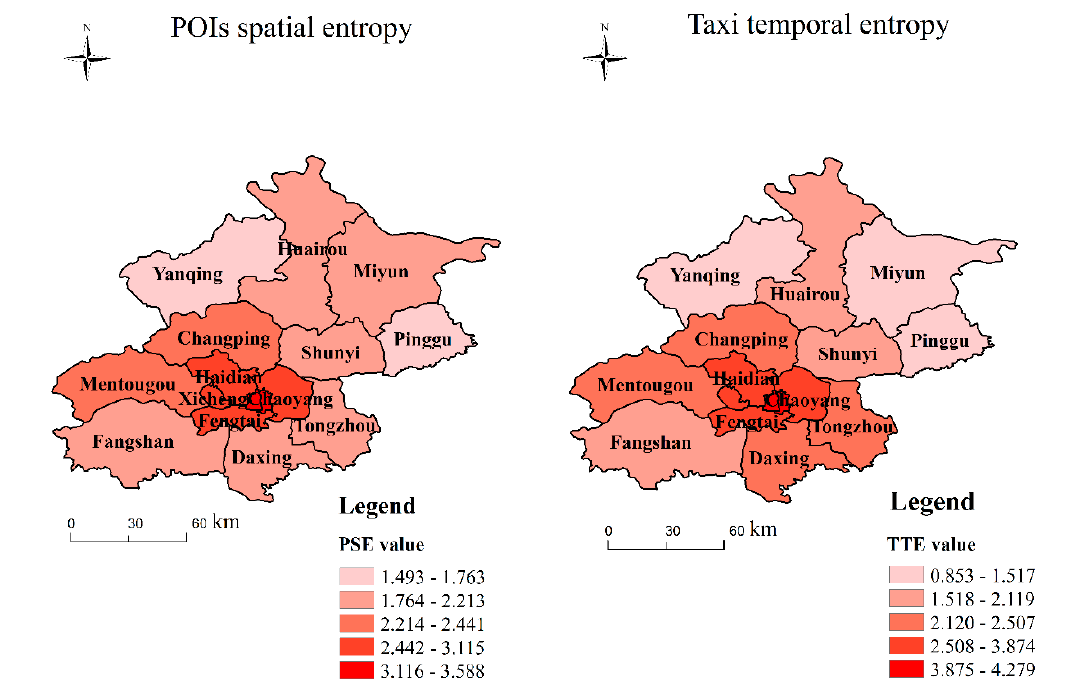
Figure 3. Distribution of POIs’ spatial entropy and taxis’ temporal entropy.